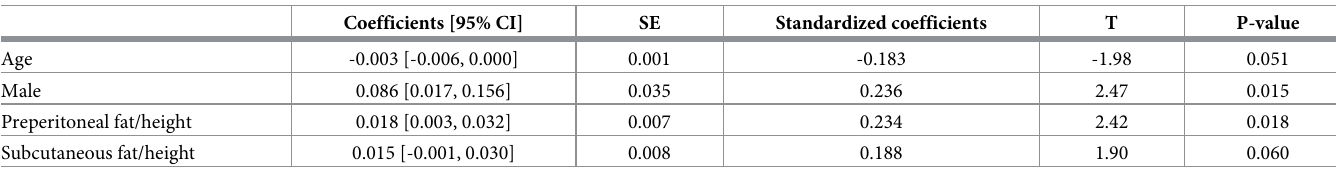
Table 6. Multiple regression analysis based on ultrasound data (30 min after the surgical